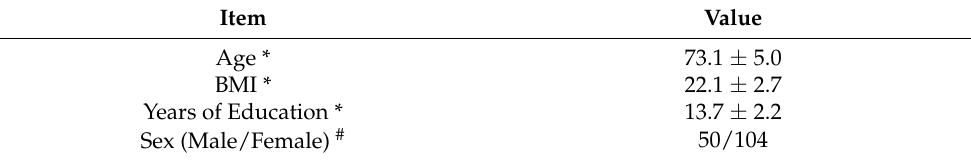
Table 1. Participant characteristics.